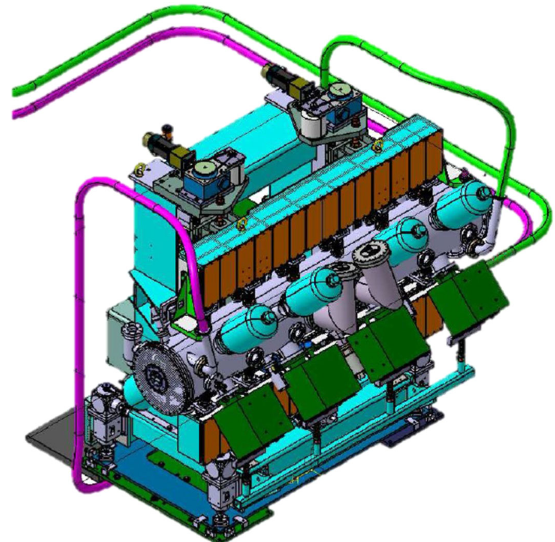
FIG. 5. Mechanical design of the cryogenic undulator using 3D CATIA